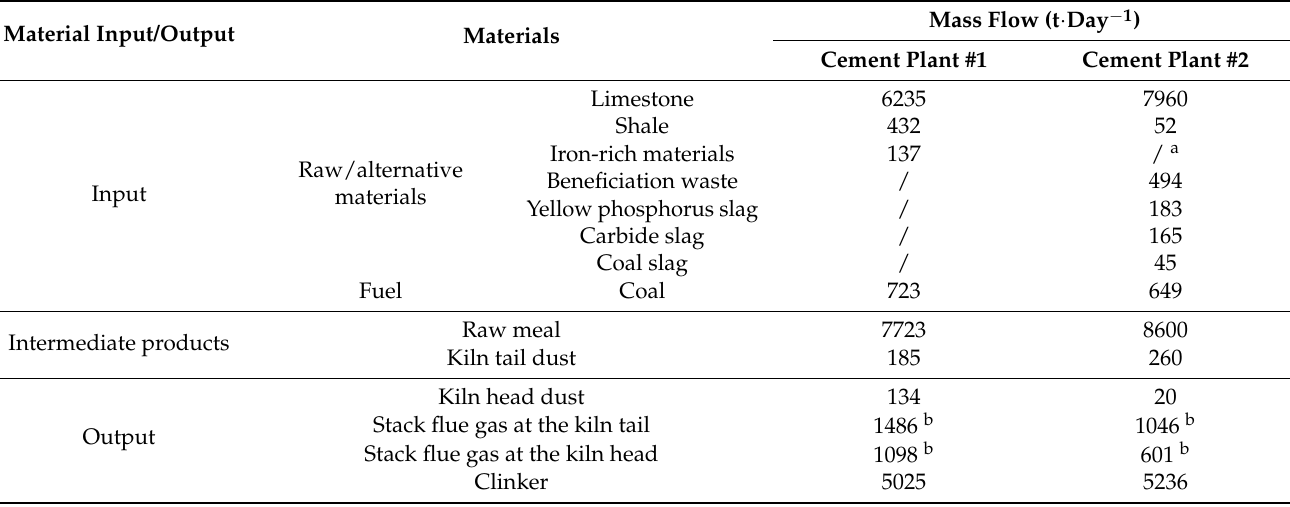
Table A3. Mass flow of solid materials during the clinker production process of the CPs.